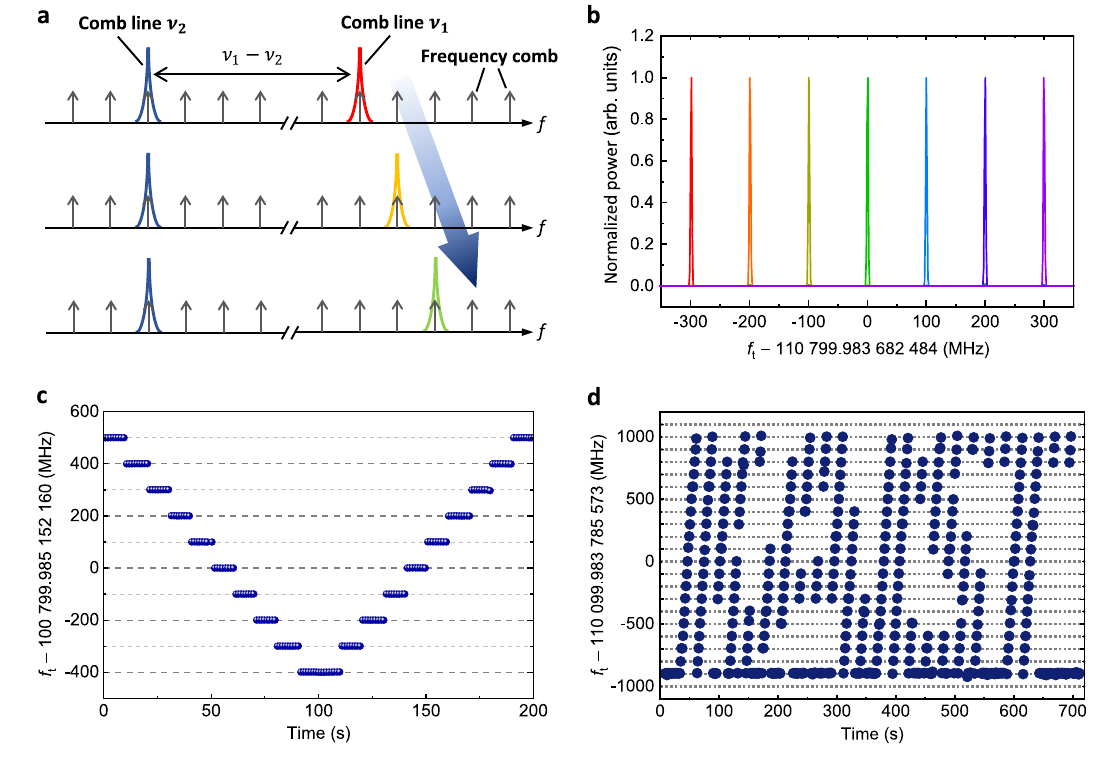
Fig. 4 | Arbitrary terahertzfrequency synthesis. a Selective comb line extraction byinjection-lockingpositioncontrol. b Normalizedterahertzfrequencyspectra.As